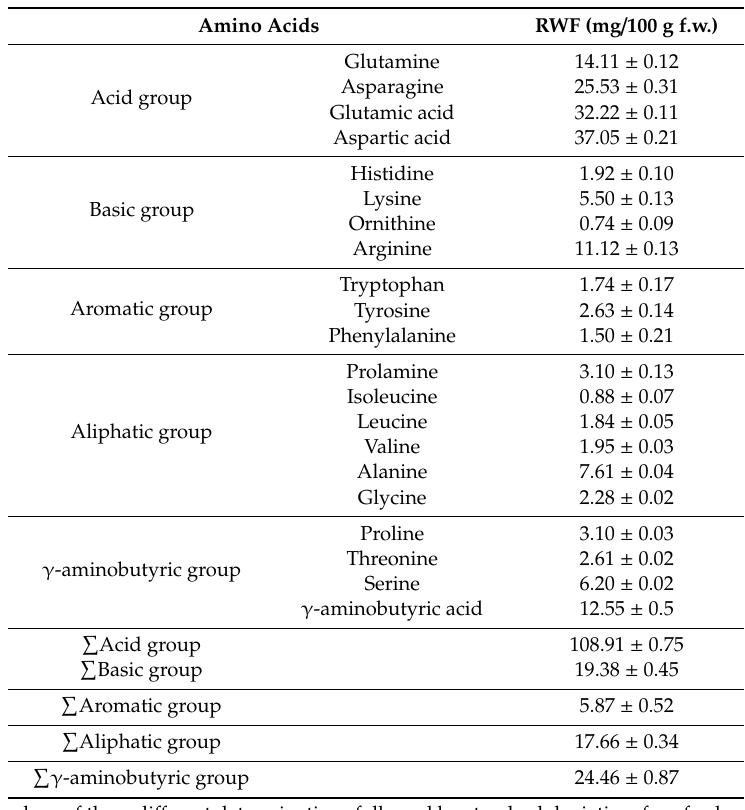
Table 1. Amino acid content of rice wholemeal flour